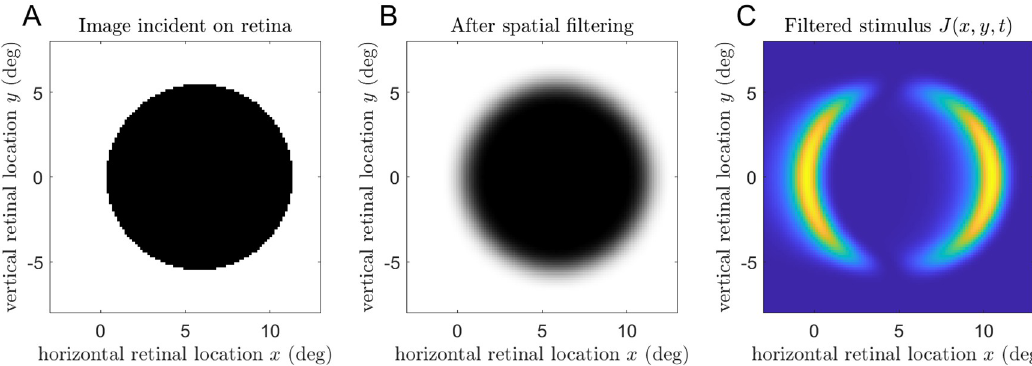
Fig 5. Spatiotemporal filtering, for a disk of diameter 11˚ moving from left to right. A: Pattern of light incident on the retina at a particular moment of time. B: After spatial filtering through a Gaussian with a standard deviation of 0.7˚, representing the acceptance angle of foveal mantis ommatidia. C: The resulting neural input, after temporal filtering and squaring. There is activity only at the leading and trailing edges of the disk, where the retinal stimulus is changing.